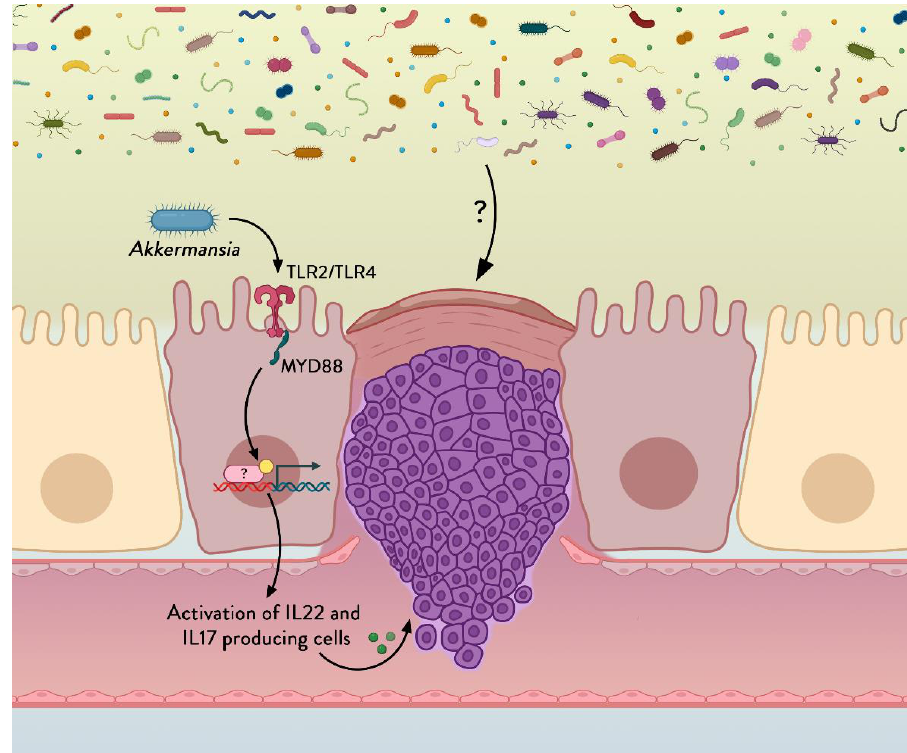
Figure 8. Working and mechanistic model proposed. A. muciniphila activates Toll-like receptors (TLRs) and a signal is transferred via the adaptor protein MYD88 leading to the expression of certain yet unknown mediators that activate the production of IL22 and IL17, which in turn results in improved wound healing and better general outcome. (?) depicted potential other unidentified signals from the gut microbiota that may also influence this